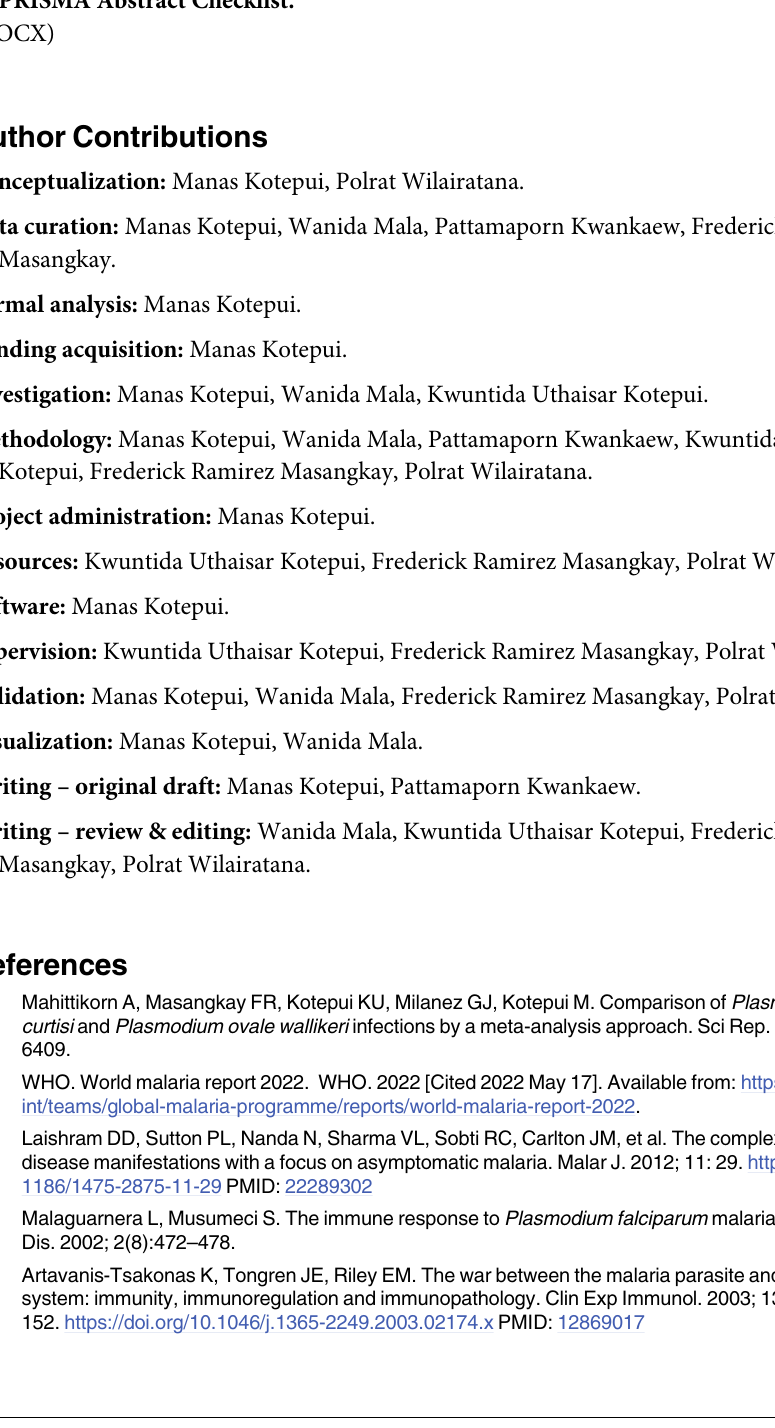
S2 Table. Details of the studies included in the systematic review and meta-analysis. S3 Table. Clinical characteristics, coinfection types, and age groups of each study. S4 Table. Quality of the included